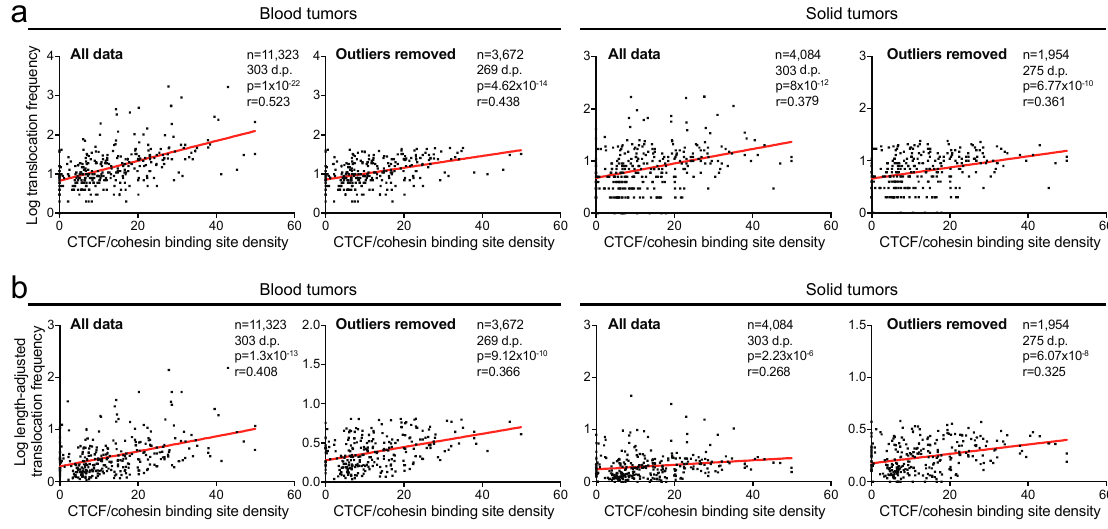
Figure 3. Translocation breakpoints preferentially occur in regions rich in CCCTC-binding factor (CTCF)/cohesin binding sites. ( a ) Scatter plots of CTCF/cohesin binding site densities in cytogenetic chromosome bands correlated with translocation frequencies within these bands in blood and solid tumors. Analyses after outlier removal are also shown. ( b ) Scatter plots of blood and solid tumors as in (a) but with translocation frequencies adjusted to the length of the bands in which they occur. D.p., data points. Statistics: see Figure 1.